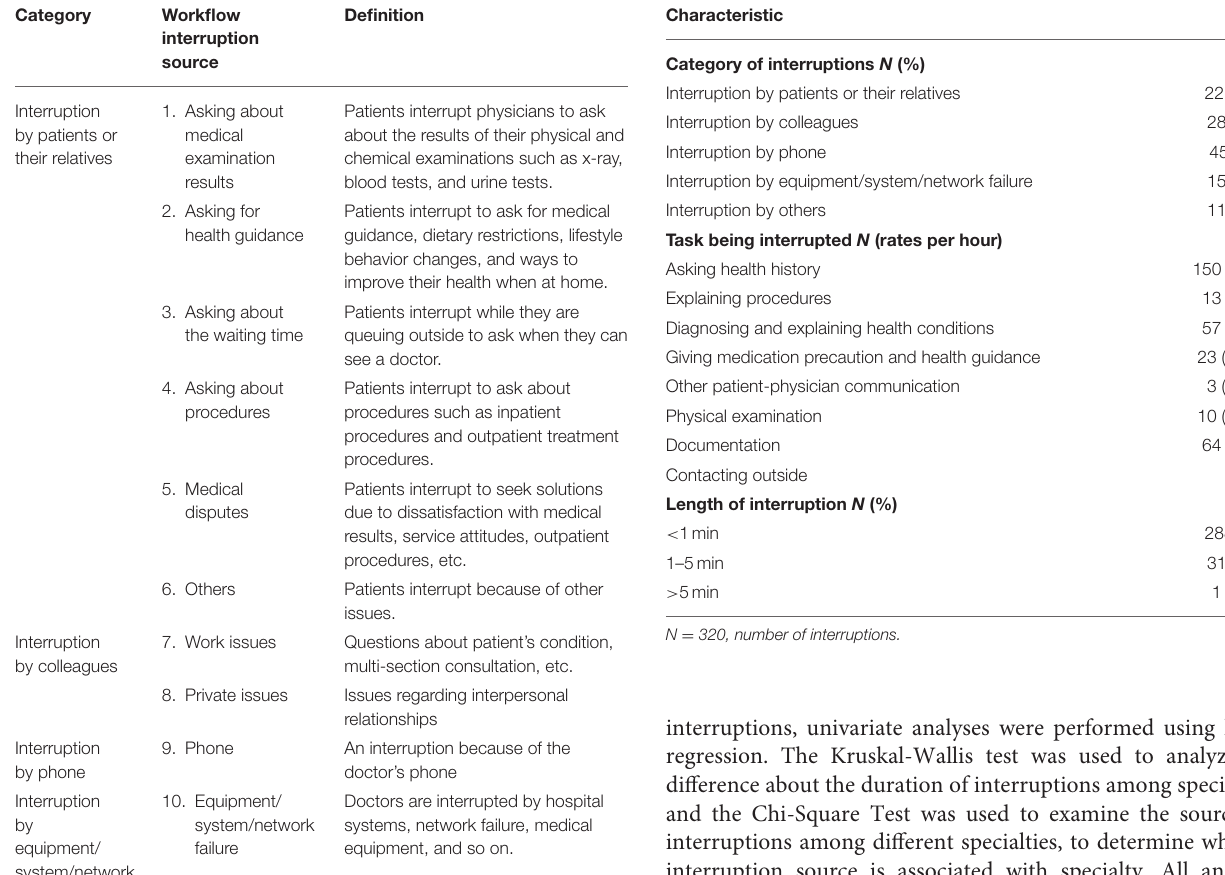
TABLE 4 | Characteristics of workflow